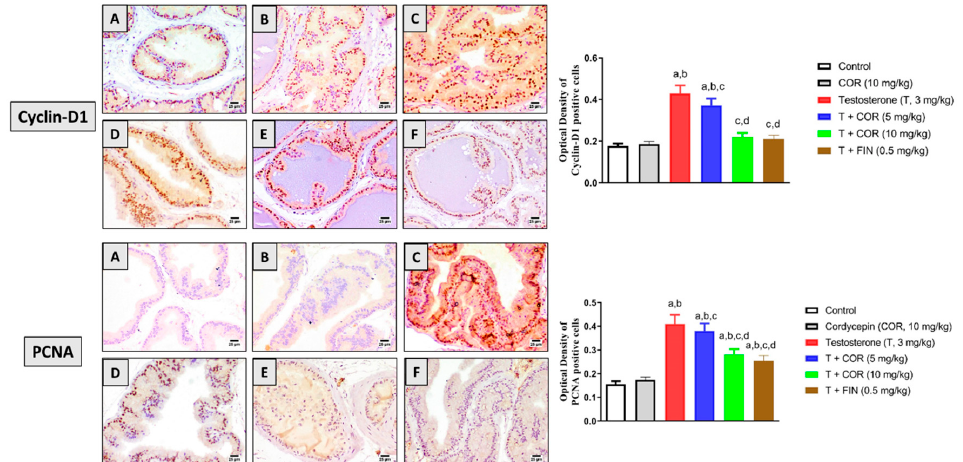
Figure 2. Effect of cordycepin on cyclin-D1 and PCNA expression as determined immunohistochemically in prostatic tissues of testosterone-treated rats. ( A ) Control, ( B ) cordycepin, ( C ) testosterone, ( D ) testosterone + cordycepin 5 mg/kg, ( E ) testosterone + cordycepin 10 mg/kg, and ( F ) testosterone + finasteride. Data presented in the bar charts ( n = 6) are mean ± SD. COR = cordycepin, T = testosterone, FIN = finasteride. a, b, c, or d: statistically different ( p < 0.05) from control, cordycepin, testosterone or T + COR (5 mg/kg), respectively.